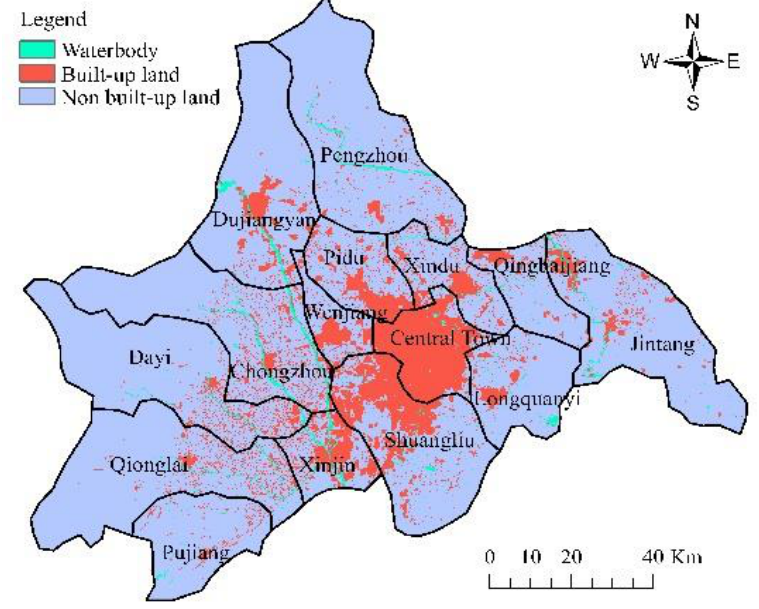
Figure 7. Simulation result of land use in 2015.